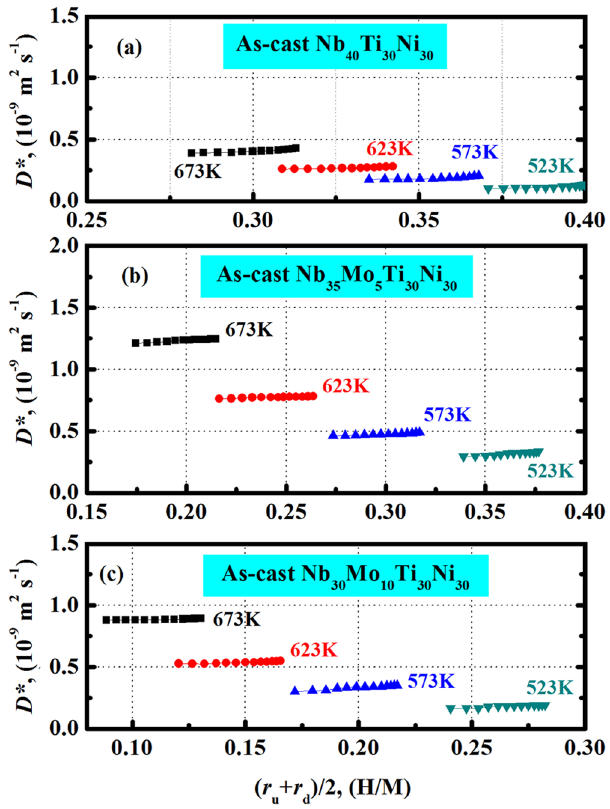
Figure 8. Concentration independent hydrogen diffusion coefficient ( D * ) for the as-cast Nb 40 Ti 30 Ni 30 ( a ), Nb